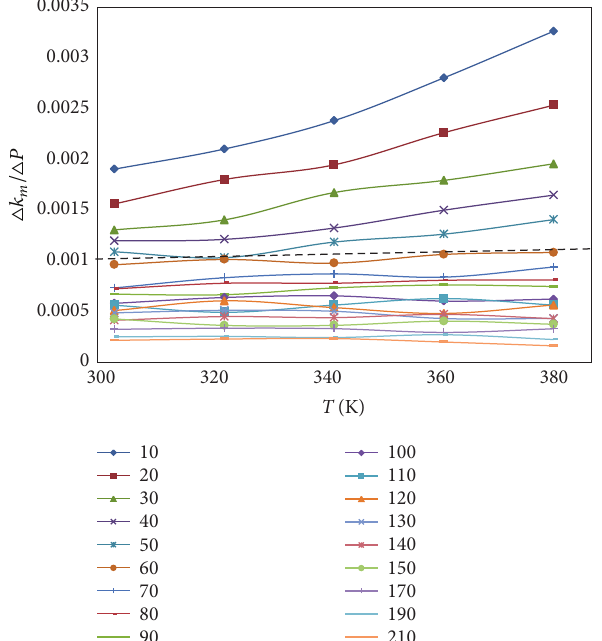
Figure 6: The trend of differential temperature ofmolecular com- pressibility temperature along various isobaric for ethyl caprate (only calculated values were revealed).